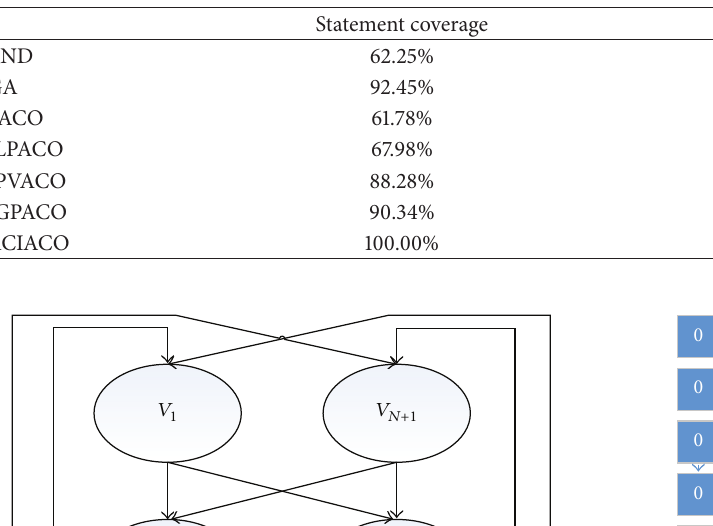
Table 2: Coverage of CTCP by seven approaches.